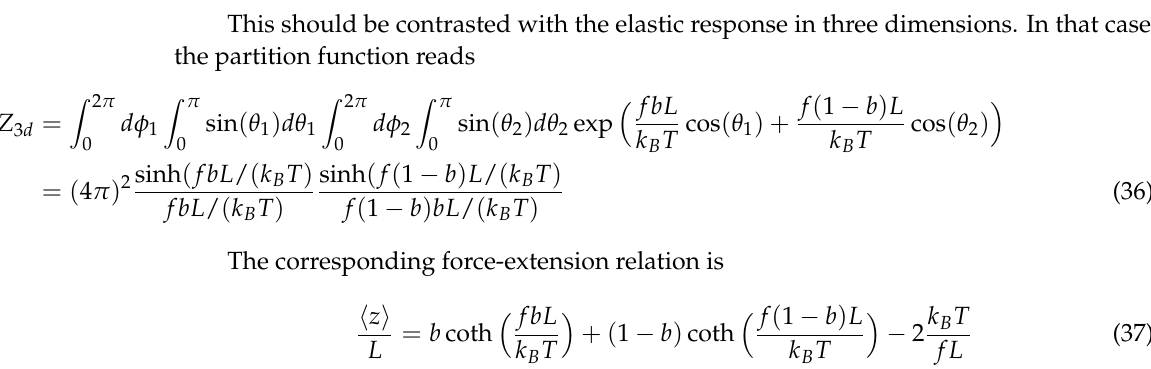
Figure 7. The average projection of the end-to-end distance n the direction of the force as a function of the hinge position for ( a ) f = k B T / L and ( b ) f = 20 k B T /